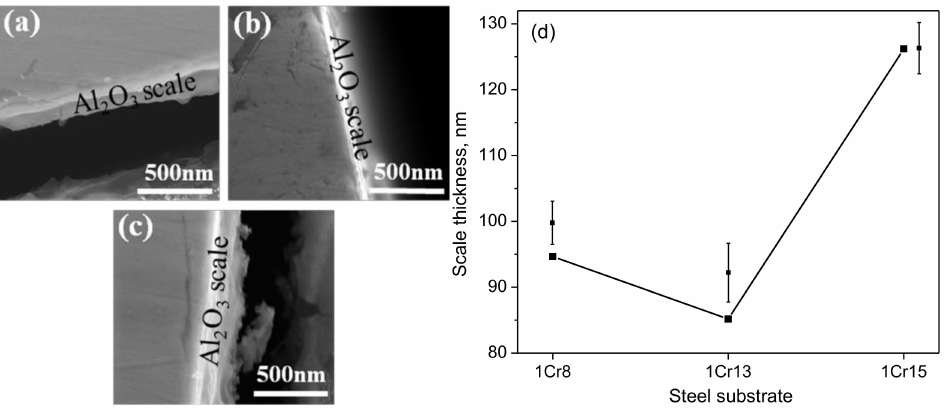
Figure 6. Cross-section features of scales formed on aluminized ( a ) 1Cr8, ( b ) 1Cr13, and ( c ) 1Cr15 steel samples after 700 ◦ C, 120 h selective oxidation in an Ar gas stream, and ( d ) the corresponding scale thicknesses determined by a reflection spectrum (RS) (the error bar is enlarged by about 10 ×